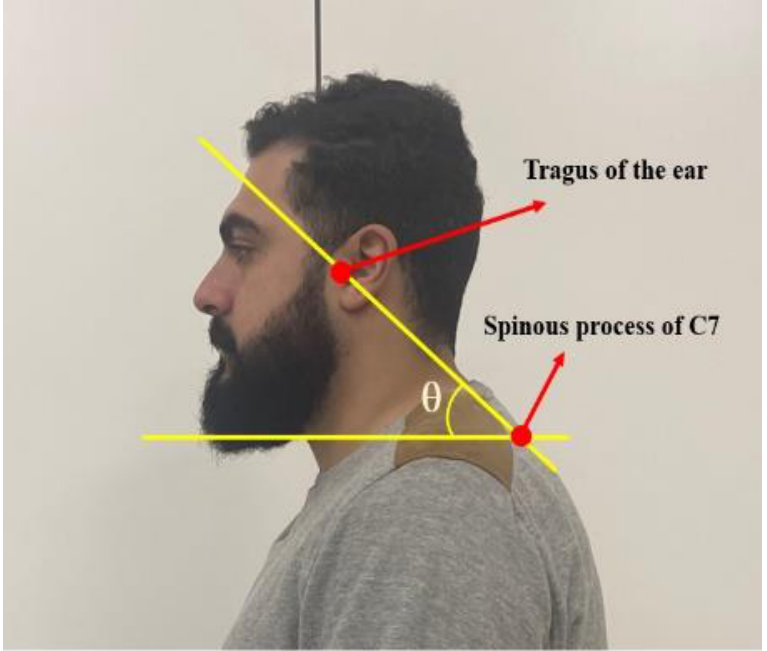
Figure 1. Measurement of the cranio-vertebral angle (CVA). The CVA is represented as the angle above. It is formed by the line connecting two adhesive markers placed at the tragus of the ear and the C7 spinous process; then, this line is assessed relative to a horizontal line drawn through the C7 marker. The angle θ represents the CVA.